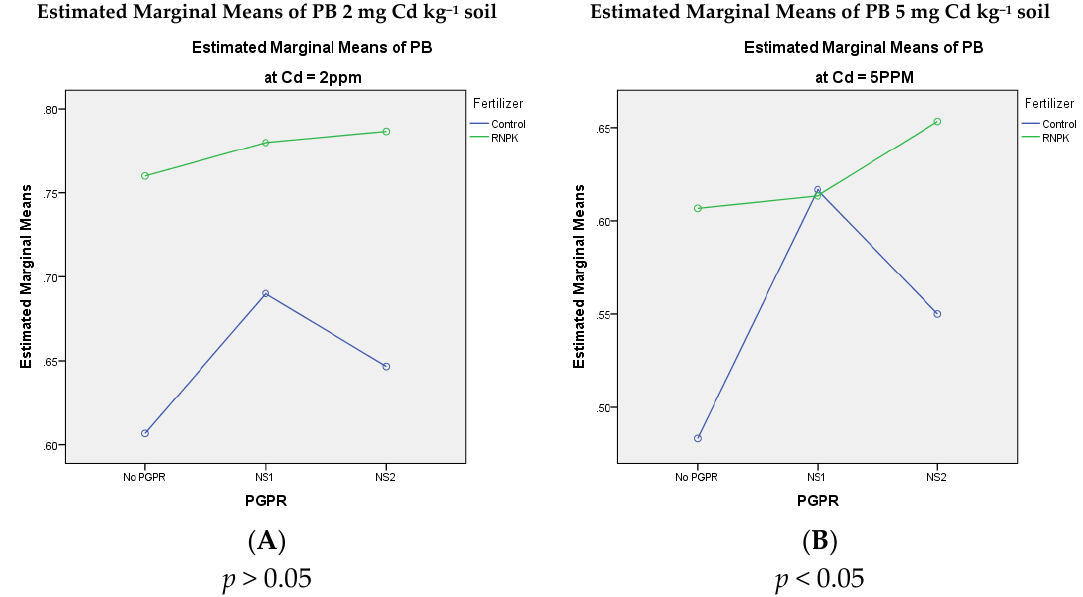
Figure 12. Interaction graphs of S. maltophilia (NS1), A. fabrum (NS2), and RNPKF at 2 ( A ) and 5 mg Cd kg − 1 soil ( B ) for phosphorus concentration in bitter gourd (PB).